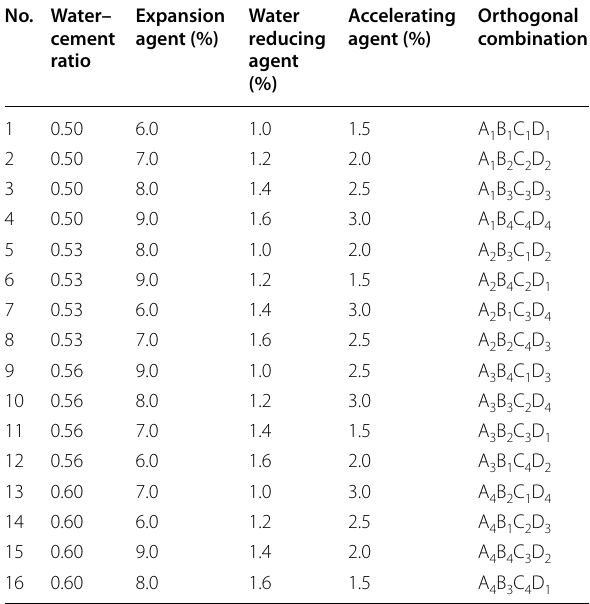
Table 6 Test scheme based on experimental design